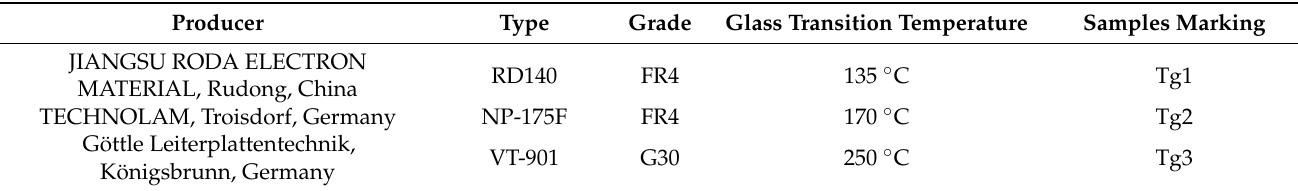
Table 1. Laminates used for the investigation.